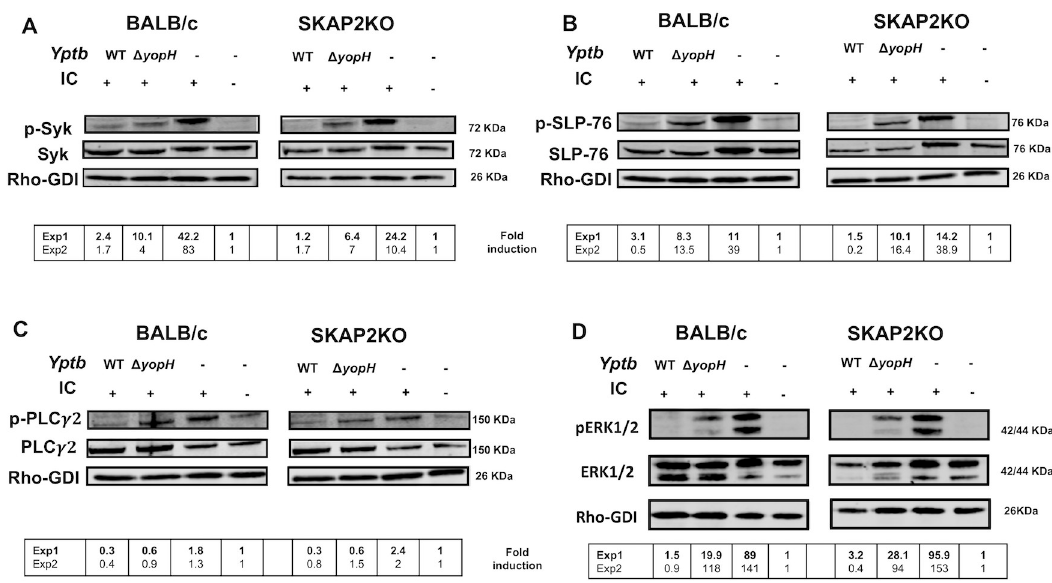
Fig 4. YopH dephosphorylates SKAP2-independent signaling proteins downstream of Fc γ R receptor. WT-BALB/c and Skap2KO BM neutrophils were uninfected or infected with YPIII WT- Yptb or Δ yopH then stimulated on IC coated surface for 5 min. Lysates were immunoblotted with (A) anti-Syk pY352 striped and then reprobed with anti-Syk, (B) anti-SLP-76 pY128 striped and then reprobed with anti-SLP-76, or (C) anti- PLC γ 2 pY1217 striped and then reprobed with anti- PLC γ 2, or (D) anti-ERK1/2 (pThr202/pTyr204) striped and reprobed with anti-ERK1/2. Anti-Rho-GDI was used as a loading control for all blots. Fold induction was calculated by dividing the normalized phospho-tyrosine signal by the unstimulated and uninfected control of each genotype. Blots shown are a representative of 2 independent experiments. Fold induction values from each experiment is shown in the lower panel with blots from experiment 1 (Exp1)